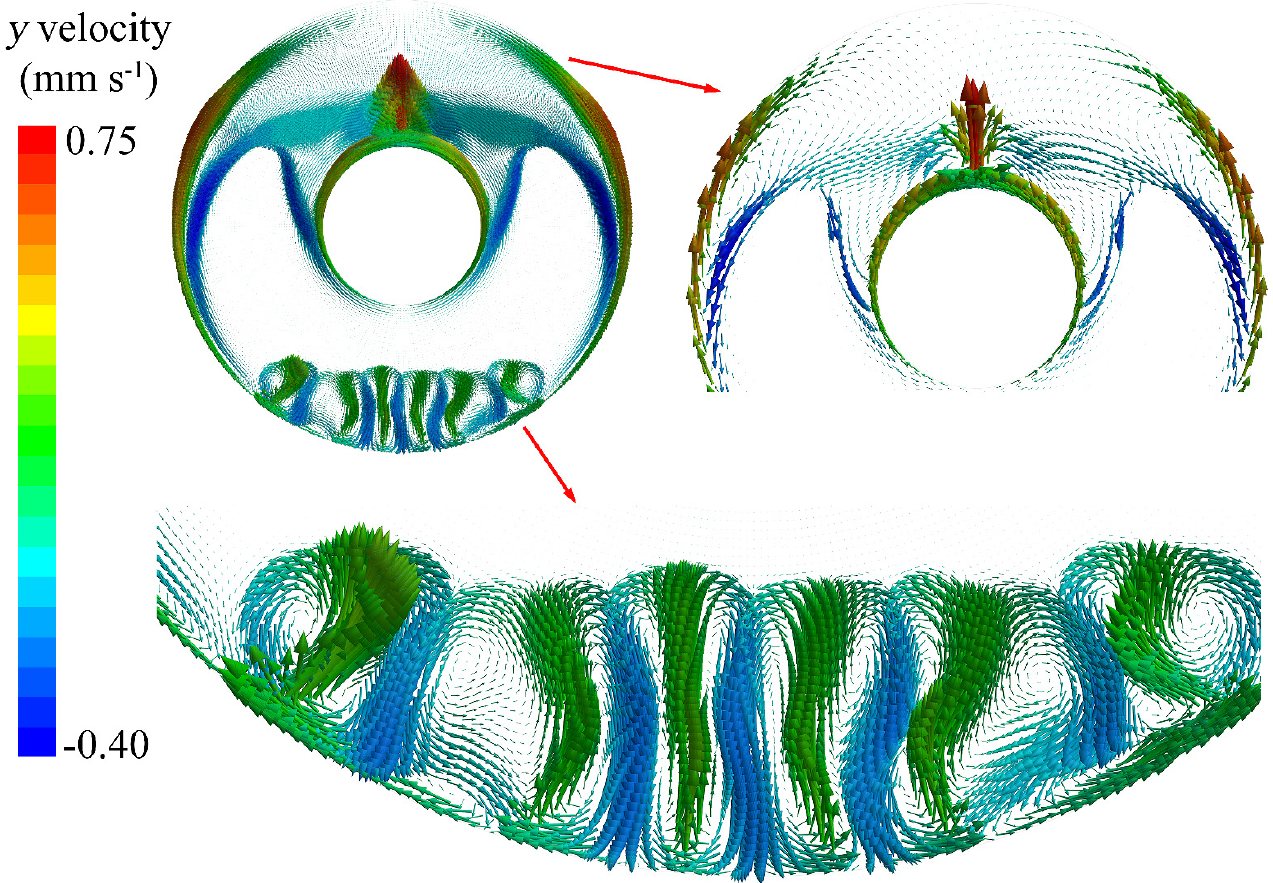
Figure 8. y velocity vectors during the PCM melting process at t = 85